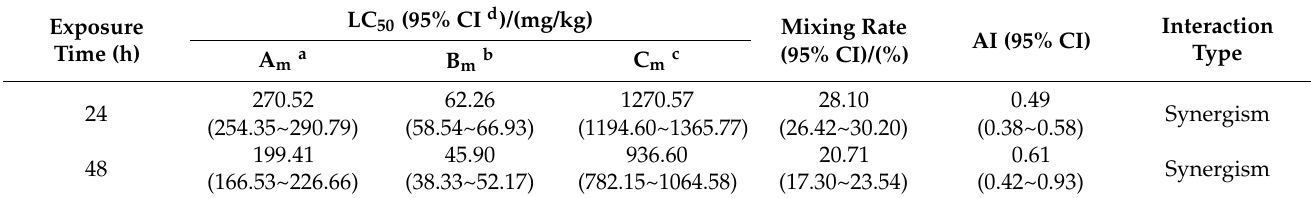
Table 3. The mixed toxicity of toluene, xylene, and trichloroethylene to E. fetida